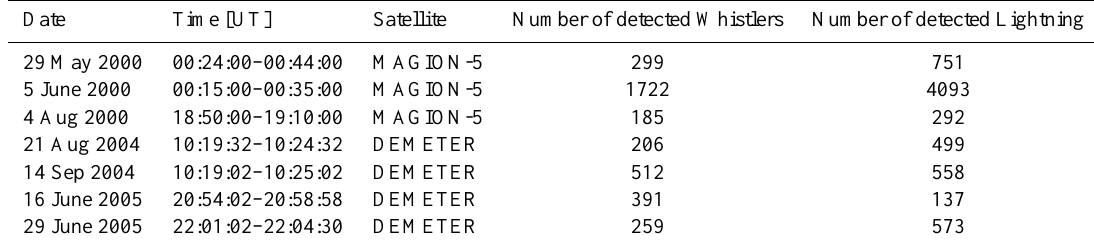
Table 2. Number of detected lightning discharges and whistlers during the analysed time intervals.